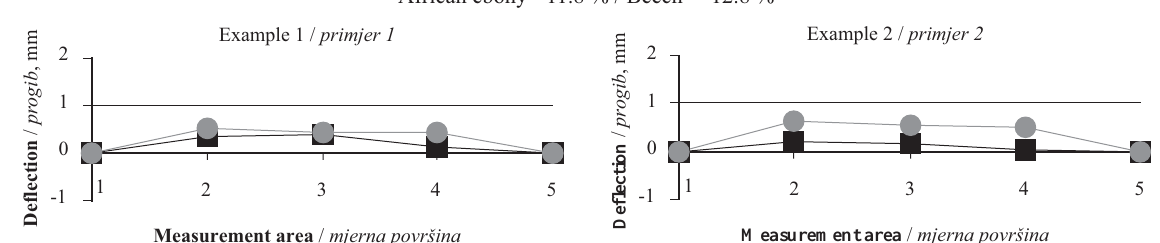
Figure 2 Defl ection of the board asymmetrically veneered on both large sides - small difference of shrinkage values Slika 2 . Progib ploče koja je asimetrično furnirana s obje strane - mala razlika između vrijednosti utezanja